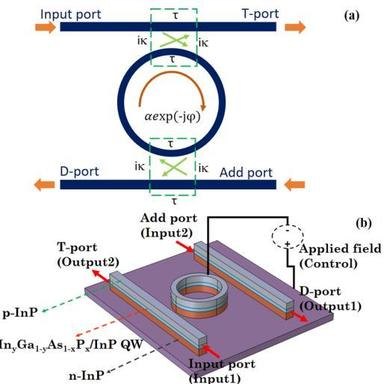
(a) Schematic diagram of a single MRR. (b) Perspective view of Fredkin gate with EA InyGa1−yAsxP1−x/InP QW based single MRR.